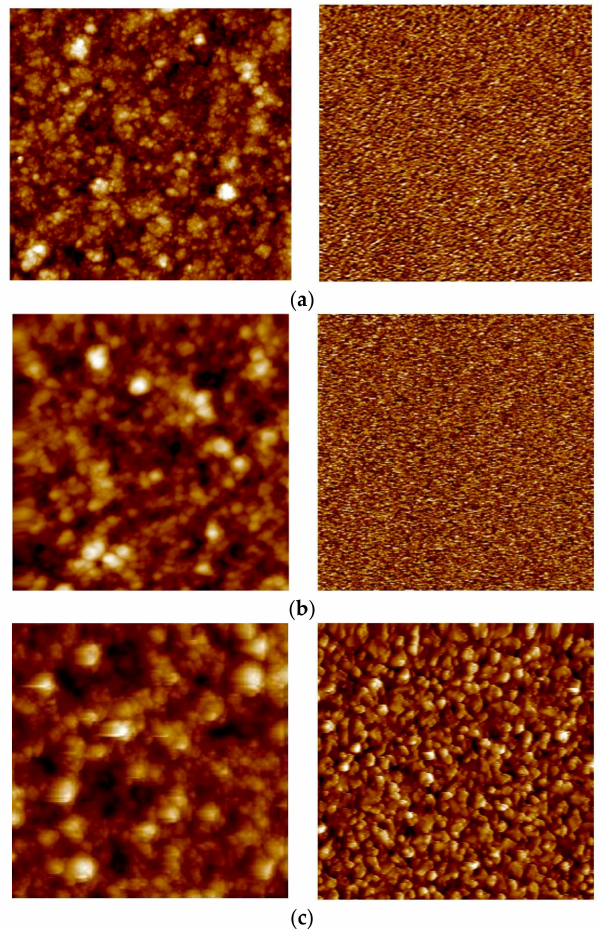
Figure 6. AFM images of the 8.5 µ m thick membrane for the feed/growth side (left panel) and permeated/substrate side (right panel) for ( a ) as-grown; ( b ) hydrogen stabilized; and ( c ) HTA-subjected samples. Image areas: ( a ) right and ( b ) right: 1 × 1 µ m 2 ; rest: 5 × 5 µ m 2